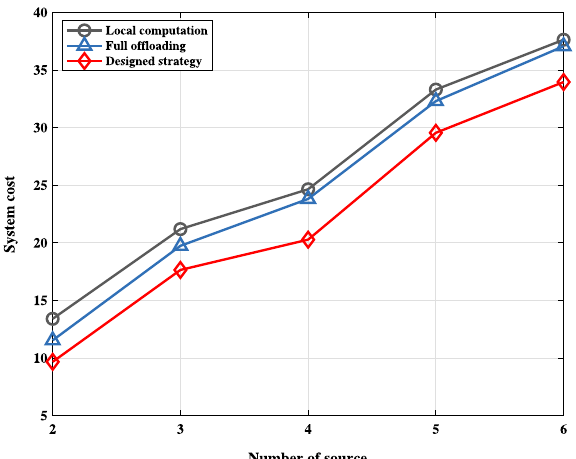
Fig. 8 The influence of the number of sources on the system